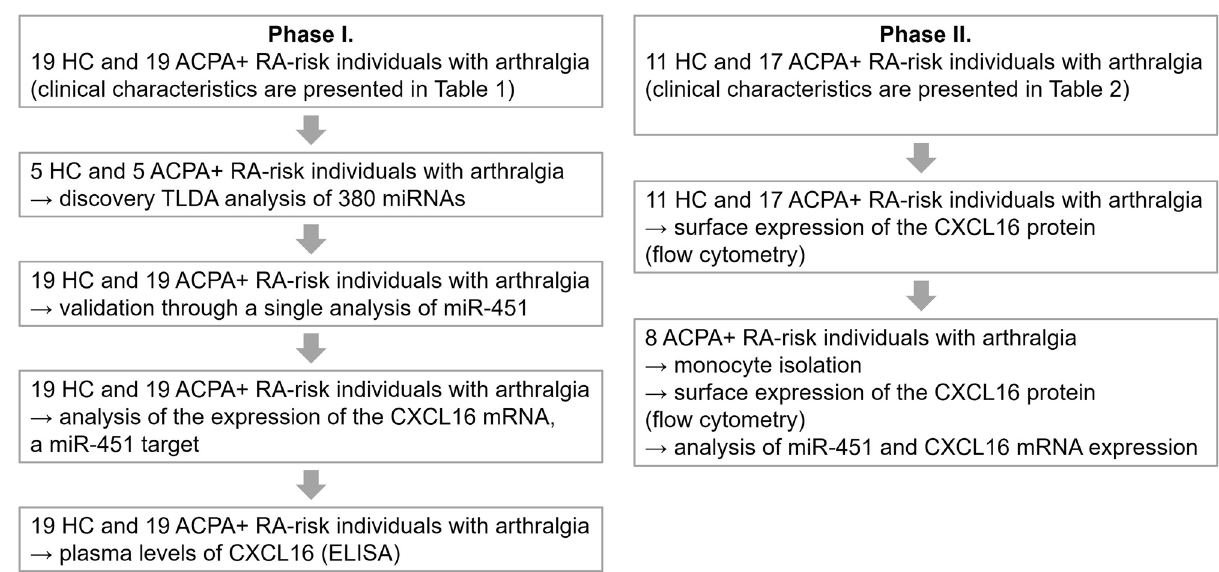
Figure 1. Workflow of our study. In Phase I, miRNAs in plasma and PBMC from ACPA-positive individuals with arthralgia at risk of developing RA and healthy controls (HC) were analysed. Phase II included a further analysis of target genes of selected miRNAs.